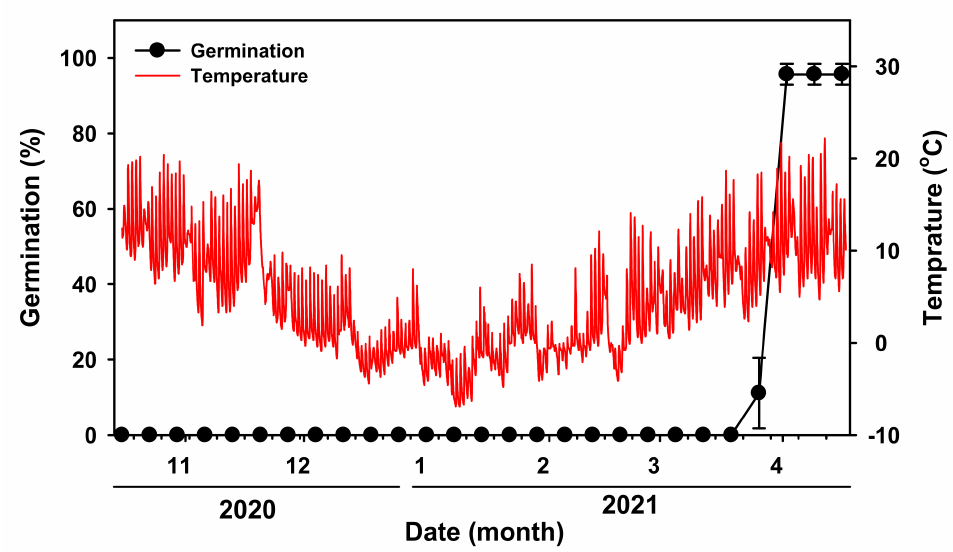
Figure 3. Phenology of germination of V. sibiricum seeds. The phenology experiment was conducted from 16 October 2020 to 16 April 2021. Vertical bars represent mean ± SE of four